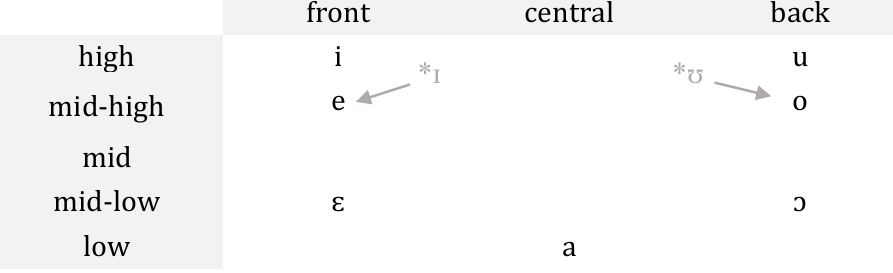
Table 4 : Typical Bantu 7-vowel system (especially in languages of the Congo rainforest; elsewhere 7-vowel languages tend to maintain the PB